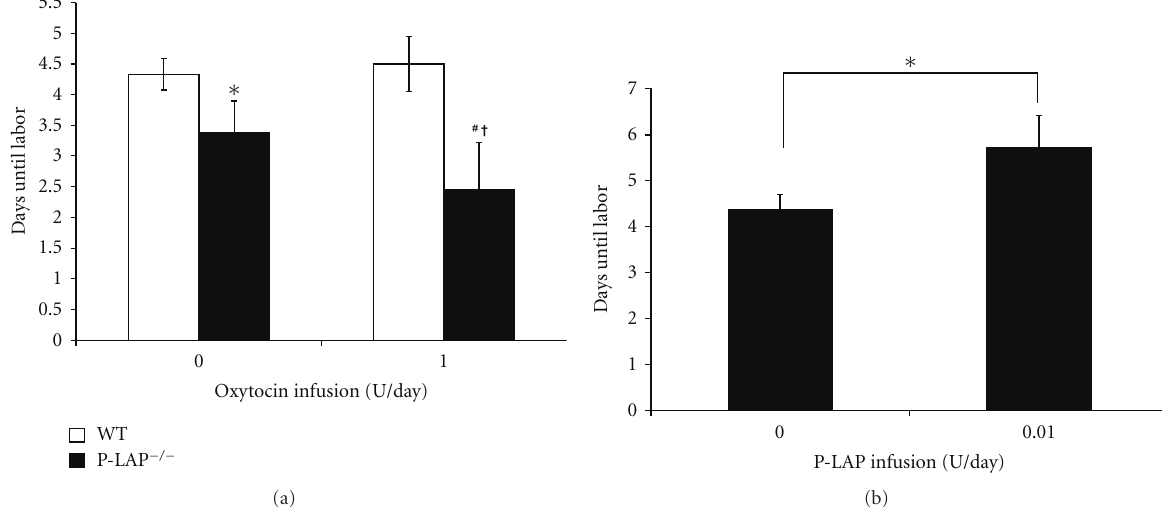
Figure 3: (a) E ff ect of OT infusion on the pregnant time in both WT and P-LAP KO mice . Values are expressed as means ± SD. ∗ P < . 05; WT mice versus P-LAP KO mice in vehicle only, # P < . 05; WT mice versus P-LAP KO mice in 1U/day OT, † P < . 05; P-LAP KO mice in vehicle versus P-LAP KO mice in 1U/day OT. (b) E ff ect of recombinant P-LAP on the pregnant time in WT mice . Values are expressed as means ± SD. ∗ P < . 05; vehicle only versus 0.01U/day